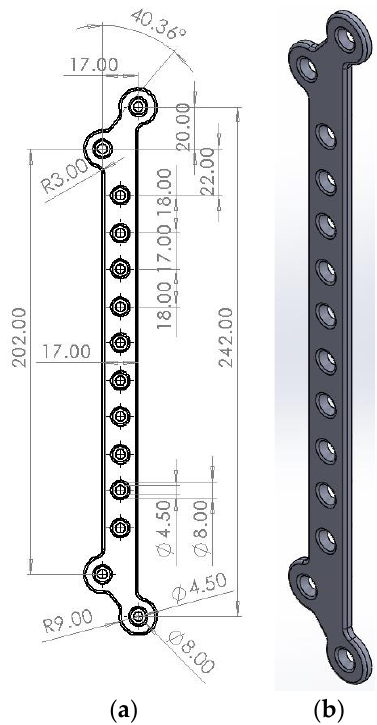
Figure 1. Traditional flat plate.